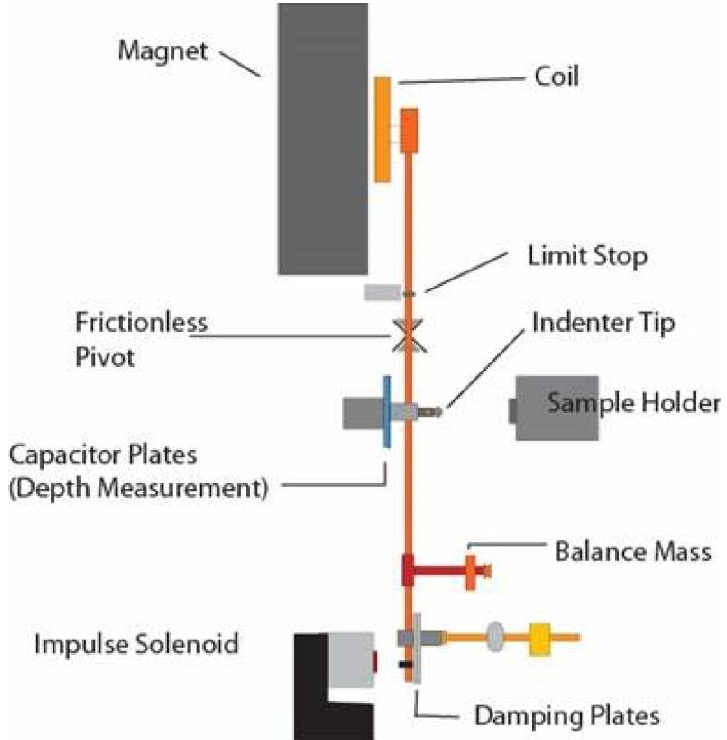
Figure 5. Schematic of the NanoTest ® instrument. The indenter is attached to a pendulum that can rotate around a virtually frictionless pivot. The indenter is loaded against the sample by passing a current through the coil, which is then drawn to the permanent magnet. Displacement of the indenter into the sample is measured by the variation in voltage between the capacitor